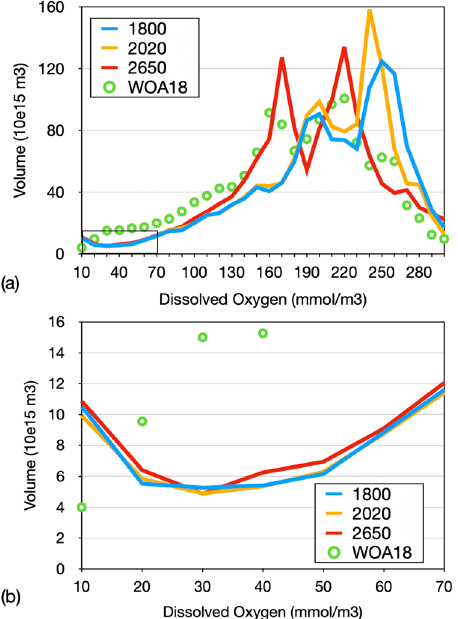
Fig. 4 Simulated water volume (10 15 m 3 ) binned according to oxygen concentration with bin width of 10 mmol m − 3 . Blue refers to year 1800, orange to year 2020, and red to year 2650. Circles refer to the data of the World Ocean Atlas 2018 51 . b The enlarged low-oxygen range marked in the lower left corner of a .